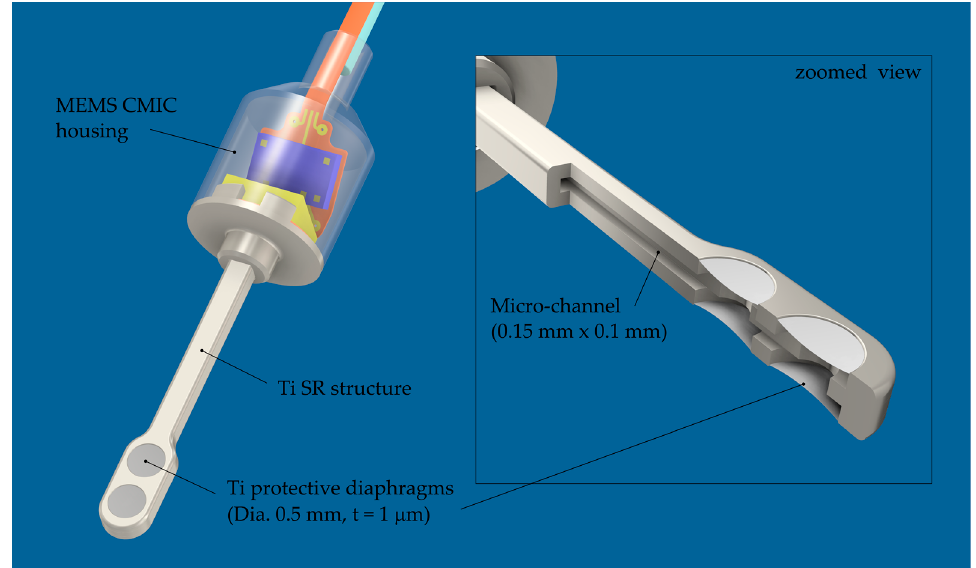
Figure 8. Drawing of the intracochlear acoustic receiver (ICAR) made from titanium and equipped with four protective diaphragms within the tip region of the sound receptor.